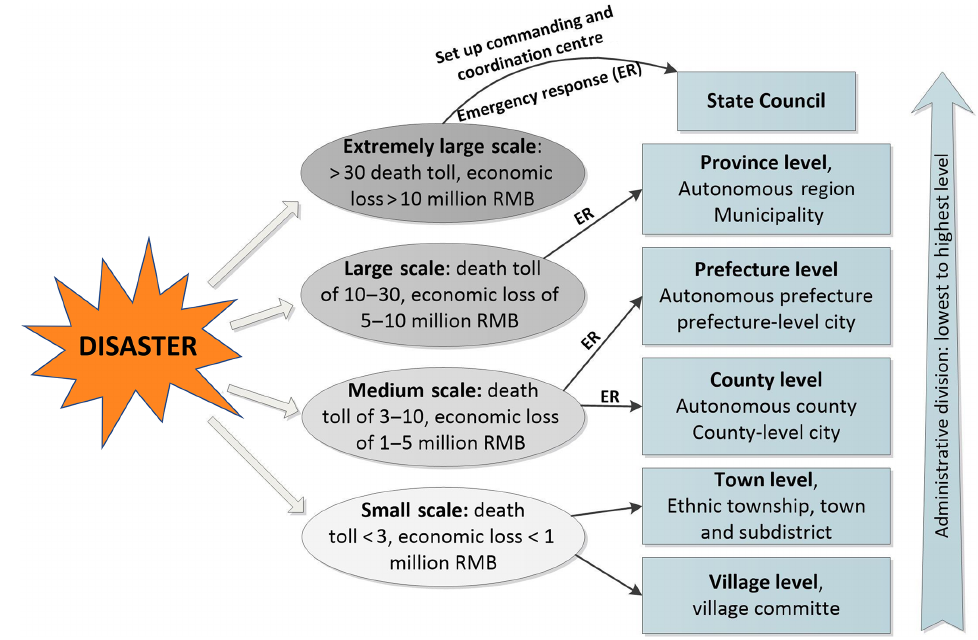
Figure 2. The emergency response to disasters in the People’s Republic of